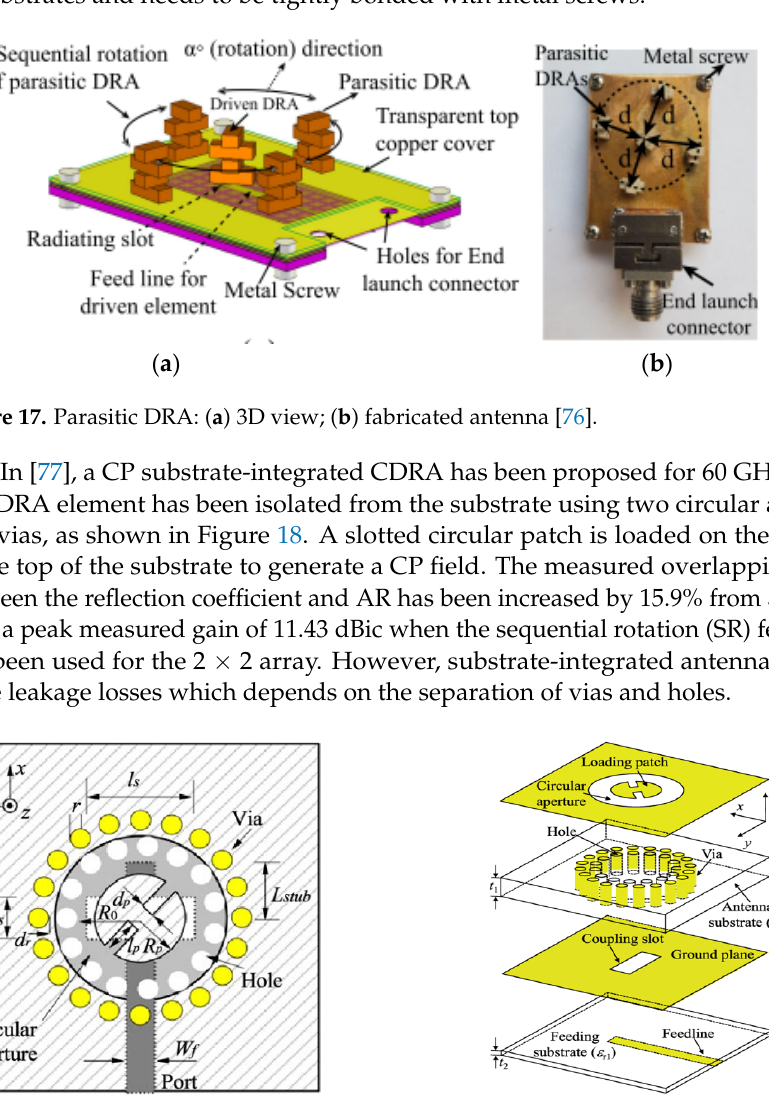
( b ) Figure 19. Proposed DRA: ( a ) perspective view; ( b ) bottom feed network [78]. Table 6. Comparison between various mm-wave circularly polarized DRAs. Ref.